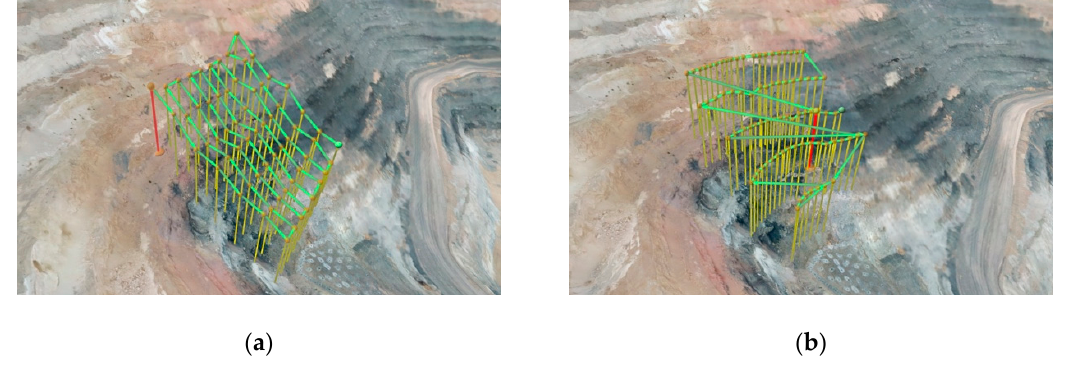
Figure 16. Illustrations of ( a ) parallel path for R2; ( b ) optimum path for R2.